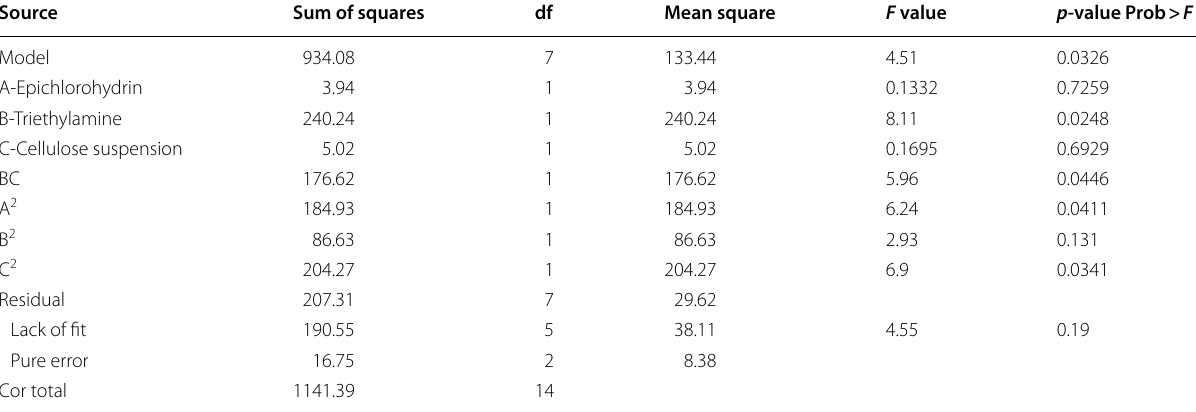
Table 4 Analysis of variance table for the model predicting zeta-potential of the chemically modified fibers Source Sum of squares df Mean